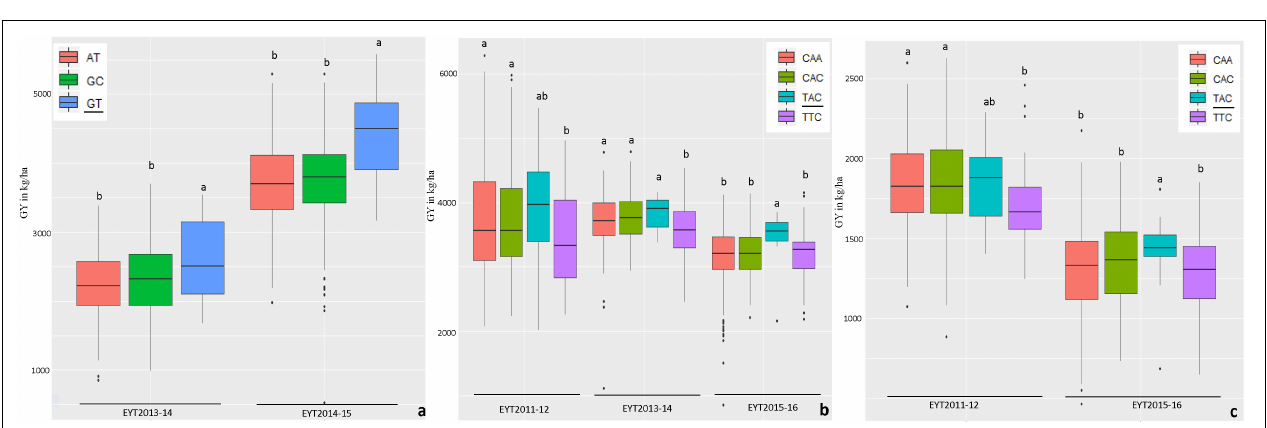
FIGURE 2 | Allelic effects of haplotypes in HB8.26 (chromosome 3B) for GY (Y axis in kg/ha) under HS (a) and HB17.1 (chromosome 6B) under B-2IR (b) and SD (c) environments. The favorable alleles are underscored based on the highest mean.